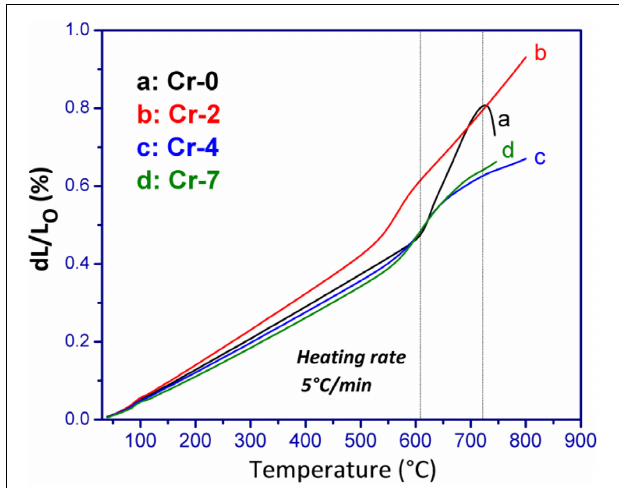
FIGURE 3 | Comparison of dilatometric thermal expansion trend (as a function of temperature) of K 2 O-MgO-Al 2 O 3 -B 2 O 3 -SiO 2 -F glasses with and without containing K 2 Cr 2 O 7 content; showing the disappearance of softening point temperature in attendance of chromium content (for composition see Table 1 ).